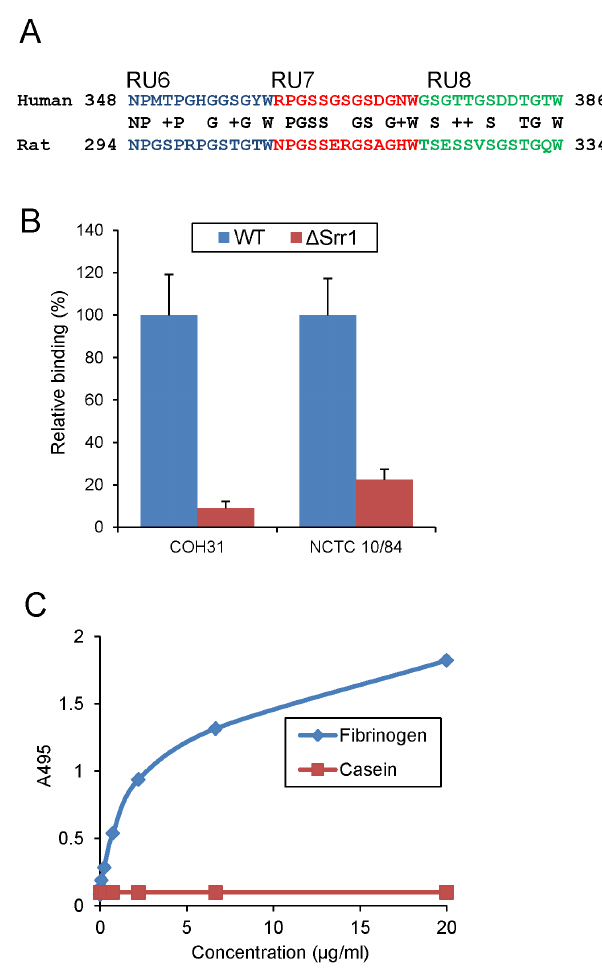
Figure 3. GBS binding to rat fibrinogen. (A) Alignment of Srr1 binding domain in the human fibrinogen A a chain, with the homologous region of the rat protein; (B) Rat fibrinogen binding by wild type GBS and their isogenic variants ( D srr1 ). (C) Rat fibrinogen binding by FLAG Srr1-BR protein over a range of concentrations. Casein served as a negative control.